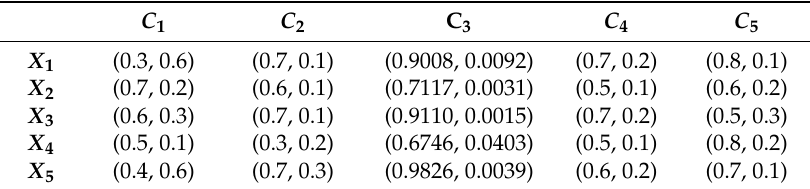
Table 6. Intuitionistic fuzzy decision matrix D 1 .